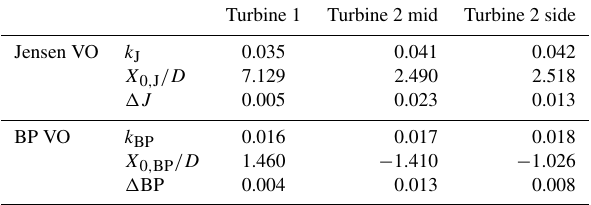
Table 5. Fit parameters and RMS errors for the altered Jensen and BP models with a virtual origin (VO) predicting the evolution of (cid:49)U/U ∞ for the three scenarios at the